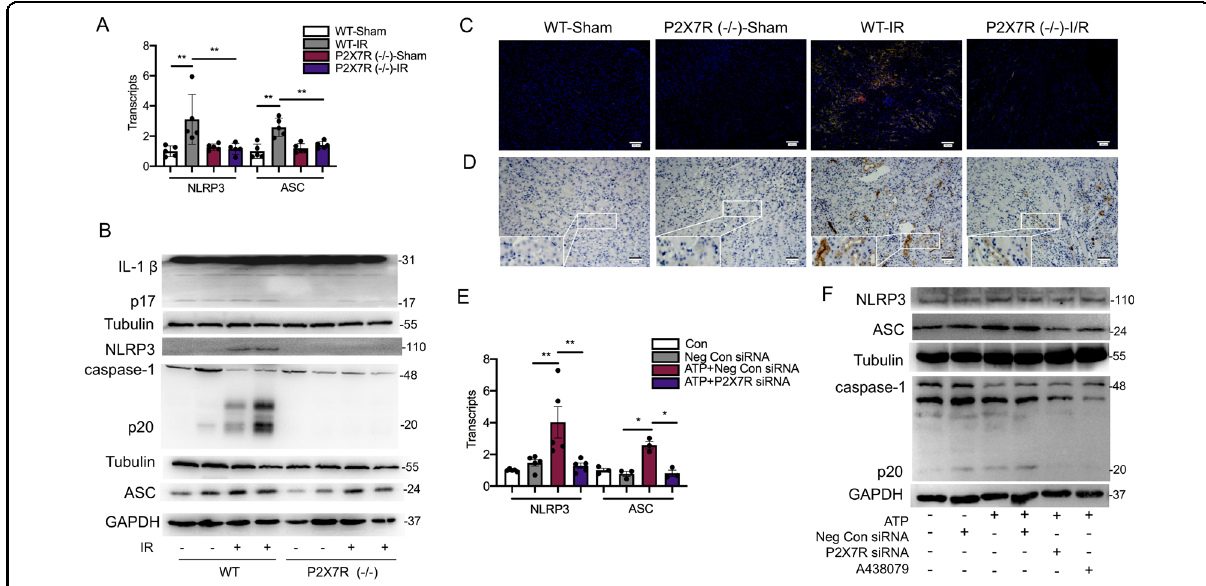
Fig. 4 NLRP3 in fl ammasome was inhibited by P2X7 receptor de fi ciency during renal ischemic-reperfusion injury. For A to D , male C57BL/6 wild-type mice and P2X7 receptor ( − / − ) counterparts were subjected to renal ischemic-reperfusion or sham operation ( n = 5 per group). A The levels of NLRP3 mRNA and ASC mRNA by real-time polymerase chain reaction. B Representative immunoblots of whole-kidney lysate for the expression of NLRP3 in fl ammasome associated proteins (IL-1 β p17, NLRP3, cleaved caspase-1, and ASC). C Representative immuno fl uorescent staining for IL-1 β (green) and NLRP3 (red) merged with DAPI (blue), and D immunochemistry for cleaved caspase-1. For E and F , HK2 cells were subjected to ATP at 4 mM, and were transfected -or not- with negative control siRNA (Neg Con siRNA) or P2X7 receptor siRNA, or treated with A438079. E The levels of NLRP3 mRNA and ASC mRNA were measured by real-time polymerase chain reaction. F Representative immunoblots of cell lysate for the expression of NLRP3, ASC, cleaved caspase-1 proteins in response to ATP at 4 mM. A438079 was applied to block P2X7 receptor at 20 µM. * p < 0.05, ** p <